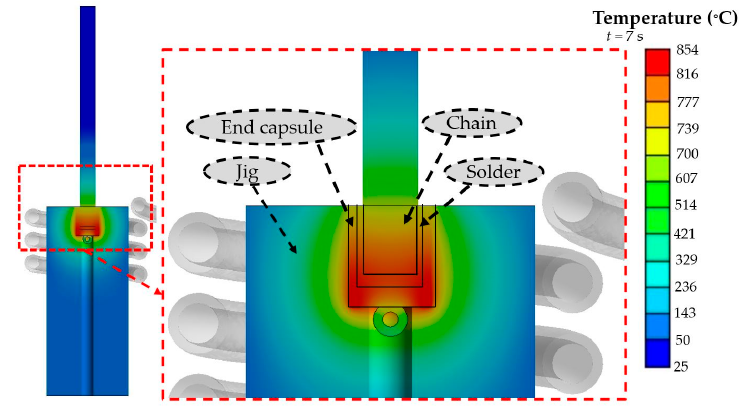
Figure 13. The temperature distribution inside the product at 7 s.